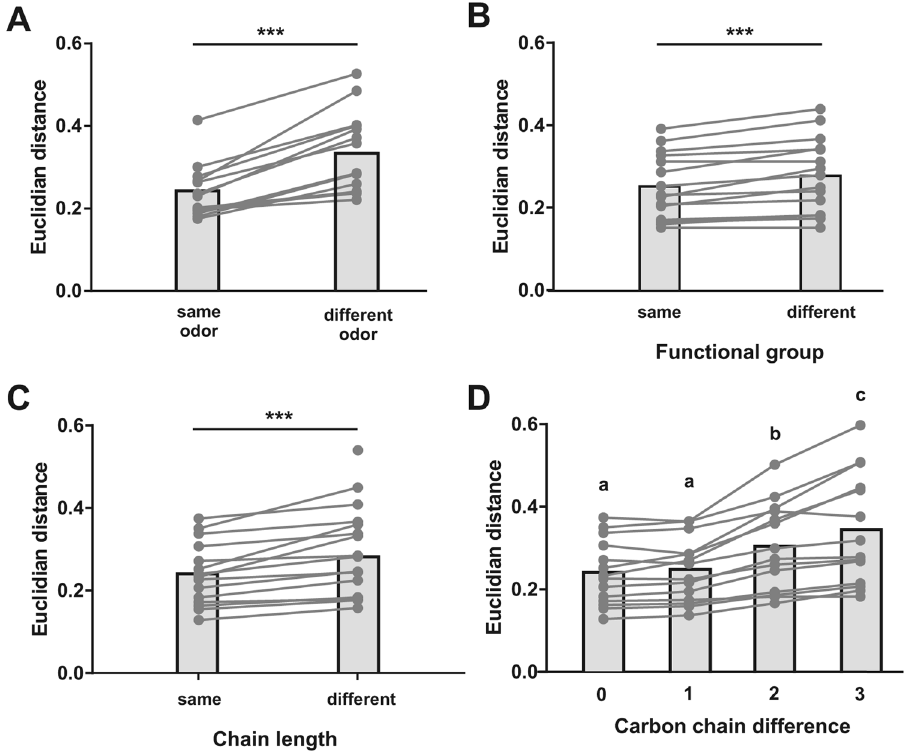
Figure 6. Odor quality coding depending on functional group or carbon chain length information. ( A ) Similarity (Euclidian distance) between presentations of the same or of different odorants. Activity maps are more similar when the same odorant is presented, showing specific odor coding in l-ALT projection neurons ( p < 0.001). ( B ) Odorants with the same functional group induce more similar activity patterns than odorants with different functional groups ( p < 0.001). ( C ) Odorants with the same chain length induce more similar activity patterns than odorants with different chain lengths ( p < 0.001). ( D ) Similarity between odorants depending on the difference in their number of carbon atoms. Euclidian distances increase (i.e. response maps are more dissimilar) with increasing difference in the number of carbon atoms ( p < 0.001; a vs. b, p < 0.01; a vs. c, p < 0.001; b vs. c, p < 0.05).